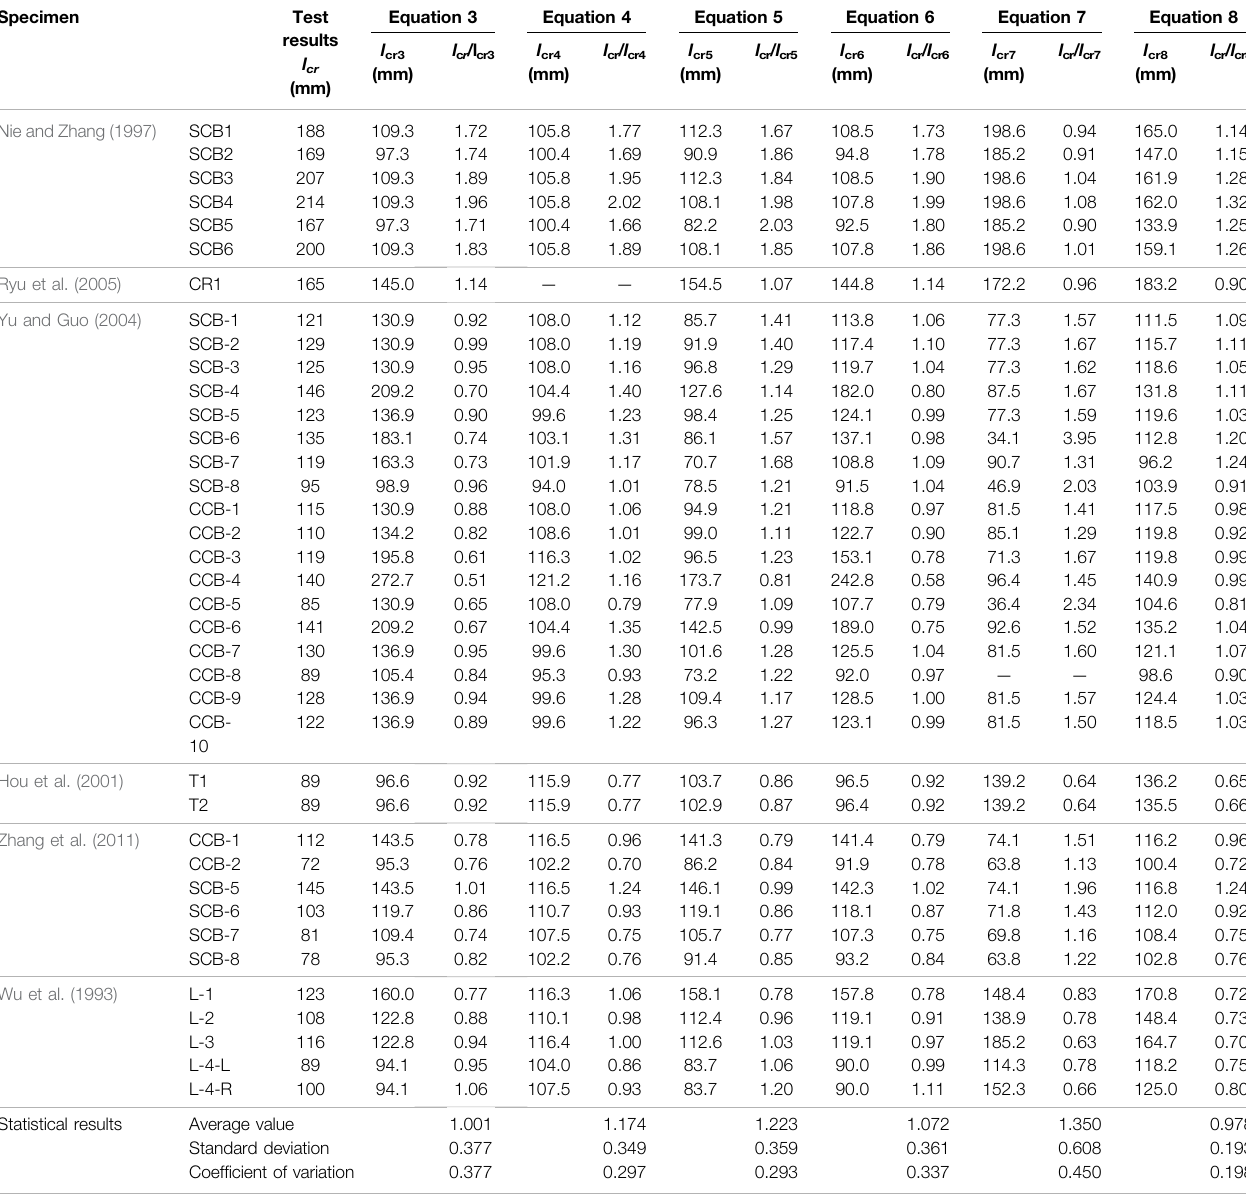
TABLE 1 | Analysis of experimental test data obtained from the existing literature.